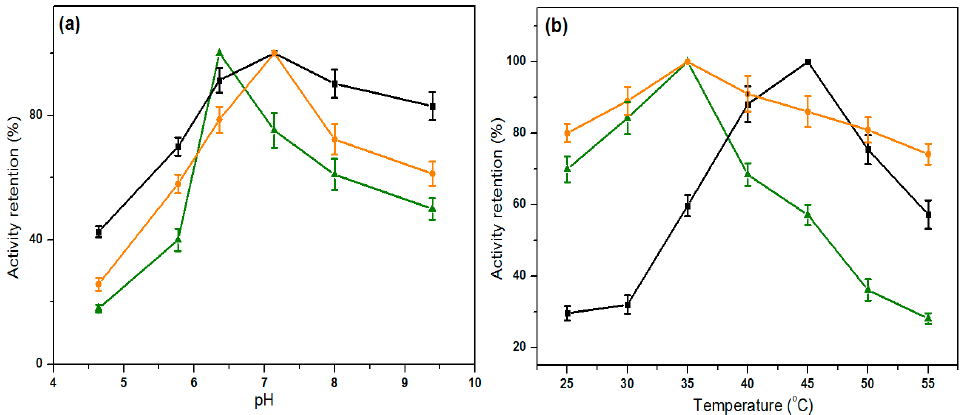
Figure 6. Influence of pH ( a ); and temperature ( b ) on activity retention. Free lipase ( ▲ , green color), lipase immobilized on pristine PPMM ( ■ , black color), lipase immobilized on PBAP ‐ modified PPMM ( ● , orange color).